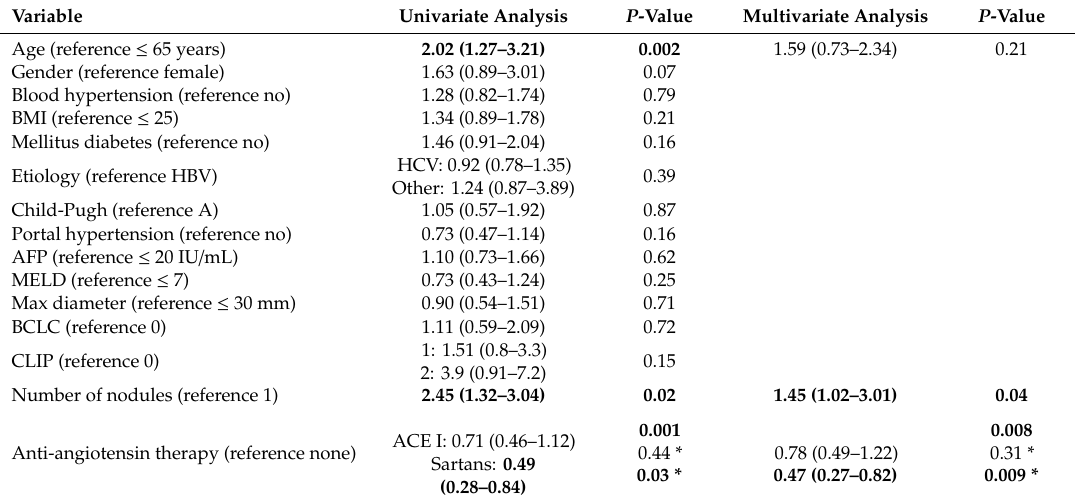
Table 3. Univariate / Multivariate analysis of prognostic factors for time to recurrence.